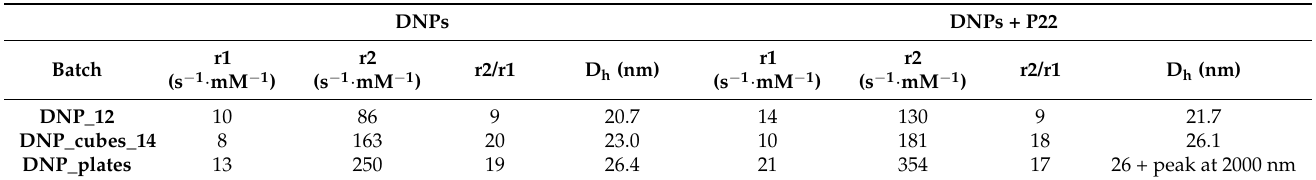
Table 7. Relaxivity values and mean hydrodynamic diameter of various batches of DNPs before and after P22 grafting measured at 60 MHz and 1.41 T.